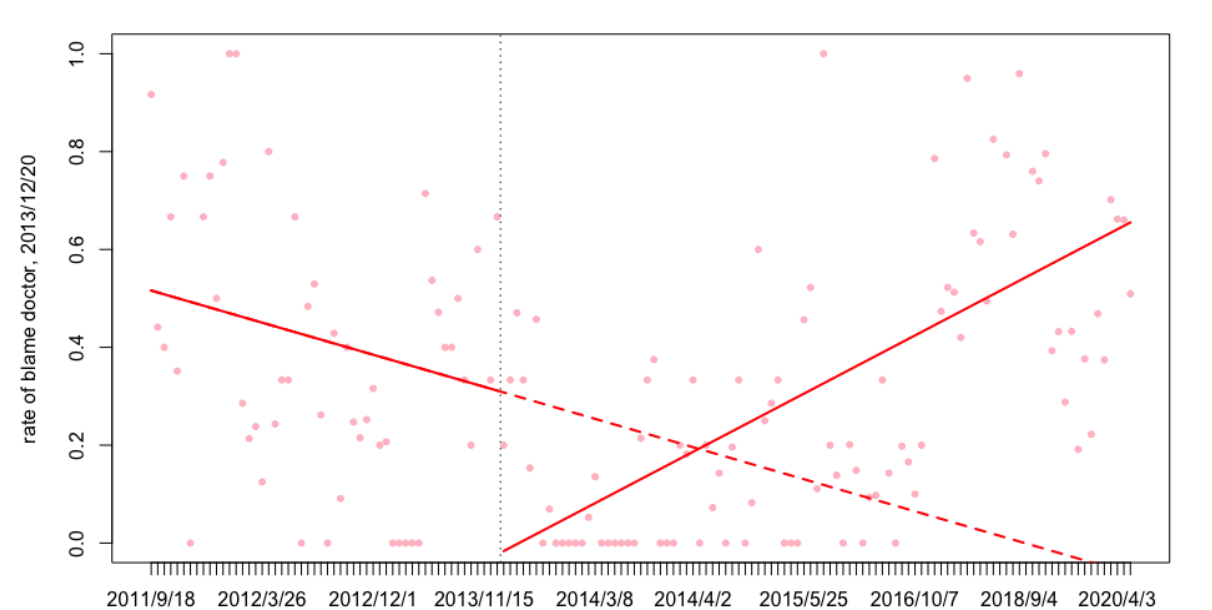
Figure 3. “Blame doctor” proportion of public online opinion over time. Trend lines show slope change after lagged intervention date. Vertical dash line shows lagged intervention date of policy 2, Dec 20,